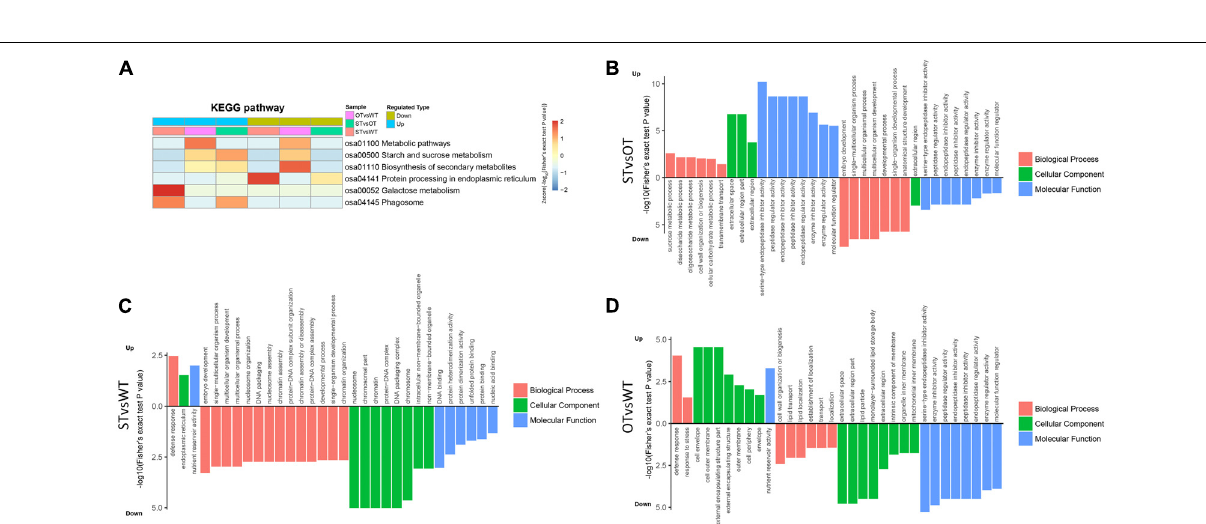
FIGURE 4 | Heat map showing the results of KEGG and GO enrichment analyses of DEPs in WT, ST, and OT seeds. (A) KEGG enrichment analysis. The greater the intensity of the red color, the greater the degree of enrichment. GO enrichment analyses of DEGs identified in STvsOT (B) , STvsWT (C) , and OTvsWT (D)